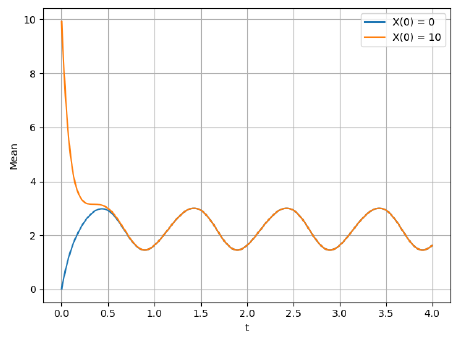
Figure 12. Average E ( t , k ) for t ∈ [ 0,4 ] at N = 10.